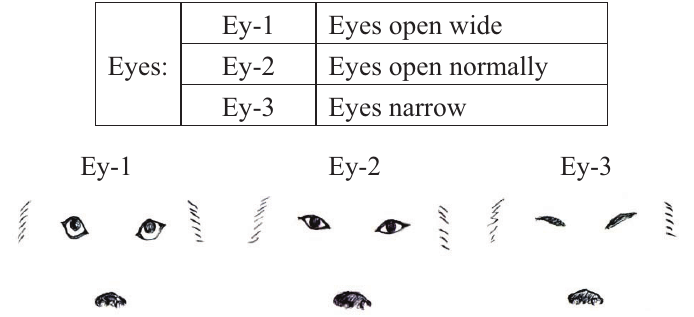
Figure 1. Categories of eyes (Ey) in dogs during their